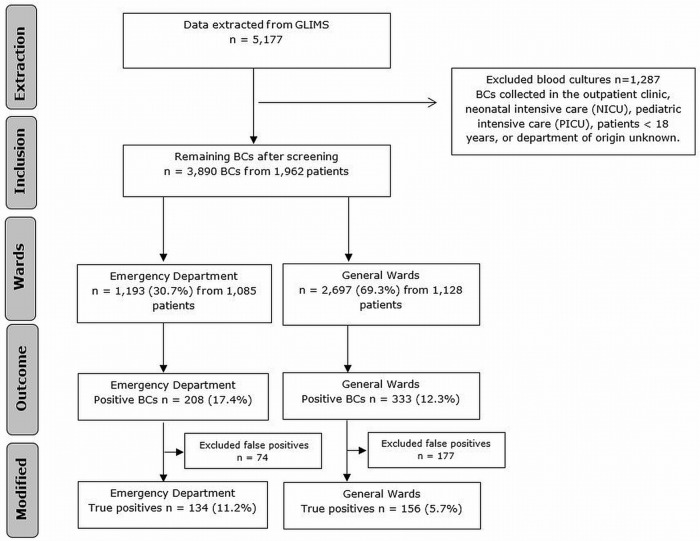
Flowchart of blood culture yield.BC = blood culture.